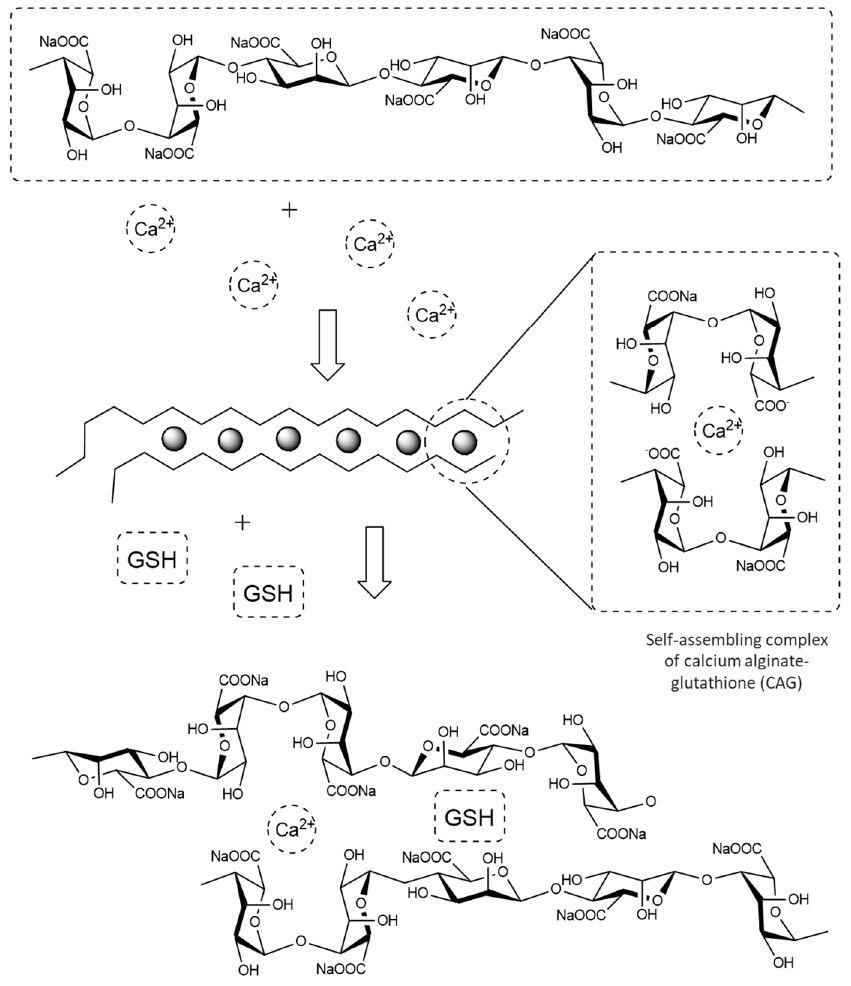
Figure 1. “Egg-box” model of calcium alginate upon exposure to Ca 2+ [29] and diagram proposal of calcium alginate–glutathione complex.